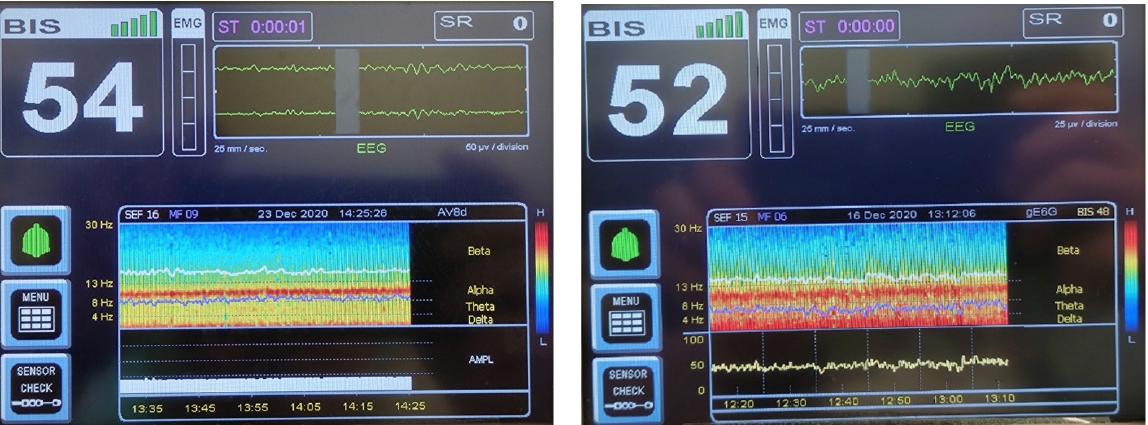
Figure 2. ( a ) ( Left ) and ( b ) ( right ). An example of intraoperative BIS monitoring with EEG DSA used